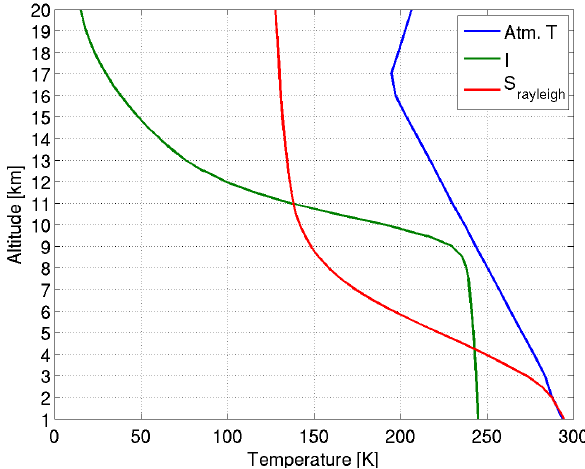
Fig. 1. Tropical mean atmospheric temperature as a function of altitude (blue), measured I cs is a function of tangent altitude (green), and the scattering source function ( S ) as a function of altitude (red). The calculation of S assumes single scattering conditions, Rayleigh conditions and that the zenith angle of ˆn is 90 ◦ (Eq. 10). The frequency is 347.5 GHz and the data represent average tropical conditions (FASCODE).